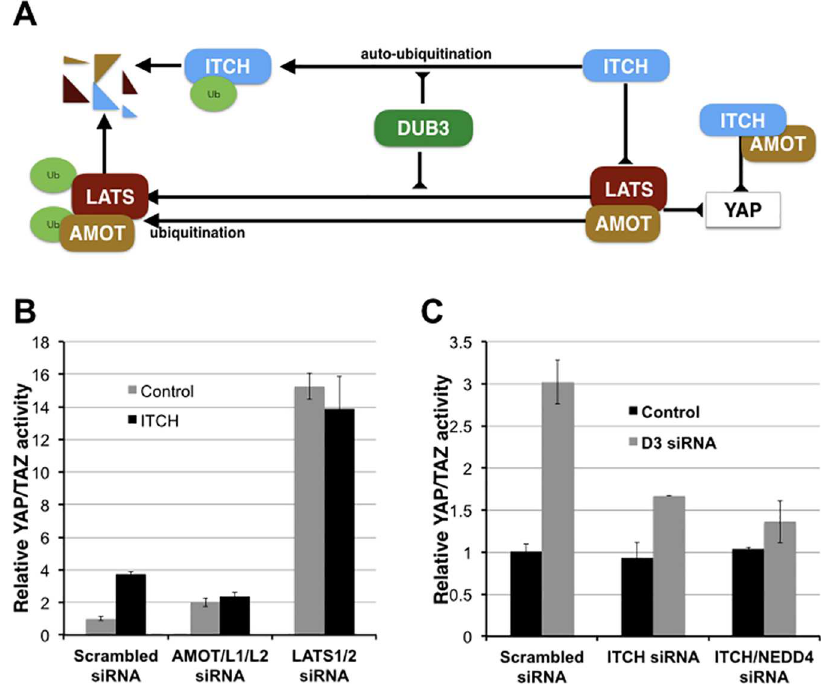
Fig 4. DUB3 mediates ITCH, LATS1/2 and AMOT proteins to regulate Hippo activity. (A) A schematic view of DUB3-mediatedregulationof Hipposignaling.DUB3 de-ubiquitylates ITCH, LATS1/2 and AMOT to promote their stability. In the presenceof stabilizedAMOT, ITCH promotes YAP degradation. (B) Luciferase reporter assays showing the effects of ITCH overexpression on YAP/TAZ activity. HEK293T cells were transfected to express the luciferase reporterstogether with a control or ITCH expressionvector in the presenceof a mixture of siRNAs targeting AMOT, AMOTL1 and AMOTL2, a mixture siRNAs targeting LATS1 and LATS2 or a scrambledsiRNA control. Data represent the averageof three independent transfection experiments ± SD. (C) Luciferasereporter assays showingthe effects of DUB3 siRNAs on YAP/TAZ activity. HEK293T cells were transfected to express the luciferase reporters togetherwith a control or DUB3 siRNA in the presenceof ITCH siRNA, a mixture of siRNAs targeting ITCH and NEDD4 or a scrambledsiRNA control. Data represent the averageof three independenttransfectionexperiments ±